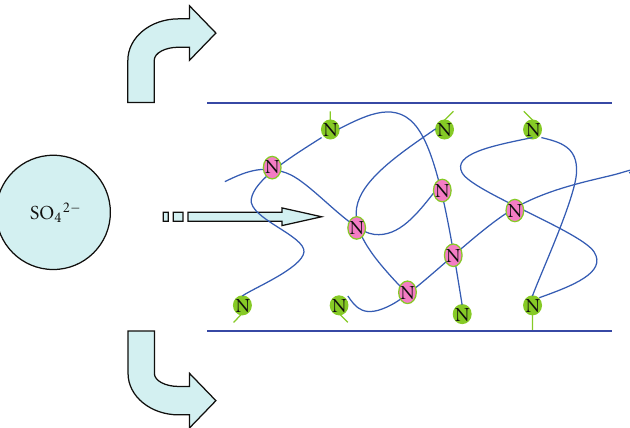
Figure 14: Mechanism of sulfuric acid di ff usion in epoxy network and intercalated layered